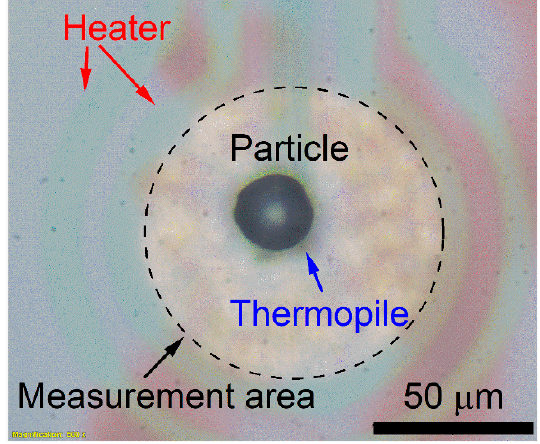
Figure 1. Single Al-20Si powder particle (Particle I) on a UFH1 DFSC sensor. After rapid solidification by DFSC at 5000 K/s cooling, the particle (Particle I) was transferred from the sensor membrane into an epoxy block. After careful grinding and polishing of the epoxy block, a cross-section of the particle was obtained. After that, the specimen was etched with Weck’s reagent for 4 s [25]. Details of the specimen preparation of one single micro-sized metallic particle for microstructure characterization can be found in [26]. Scanning electron microscopy (SEM) (Zeiss Merlin VP Compact, Oberkochen, Germany) was used to characterize the microstructure (cross-section) of the par- ticle.